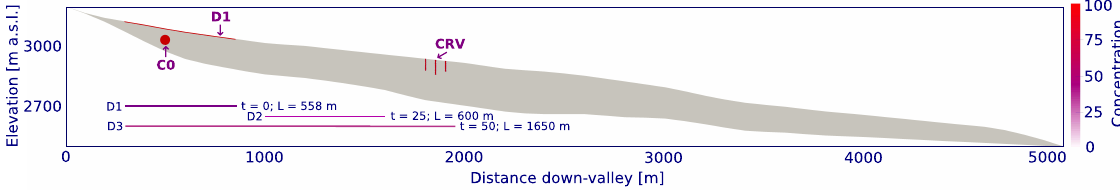
Figure 4. Debris concentration at time step t = 0 years, where C0 indicates the circular debris inclusion, D1–D3 the surface debris layer deposits and CRV the crevasse fills. The horizontal lines indicate the location and extent of the additional debris layers deposited at the surface at the stated times. L indicates the horizontal distance of the glacier surface where debris is